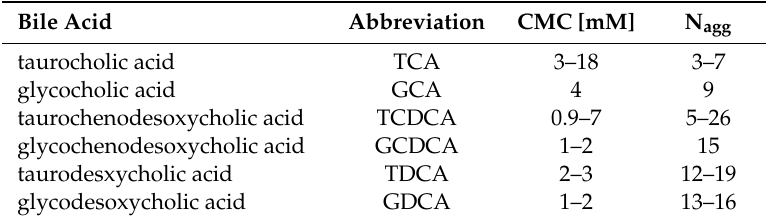
Table 4. Critical micelle concentration (CMC) and aggregation number (N agg ) of main bile acids as summarized by Parker et al. taken from Madenci and Egelhaaf